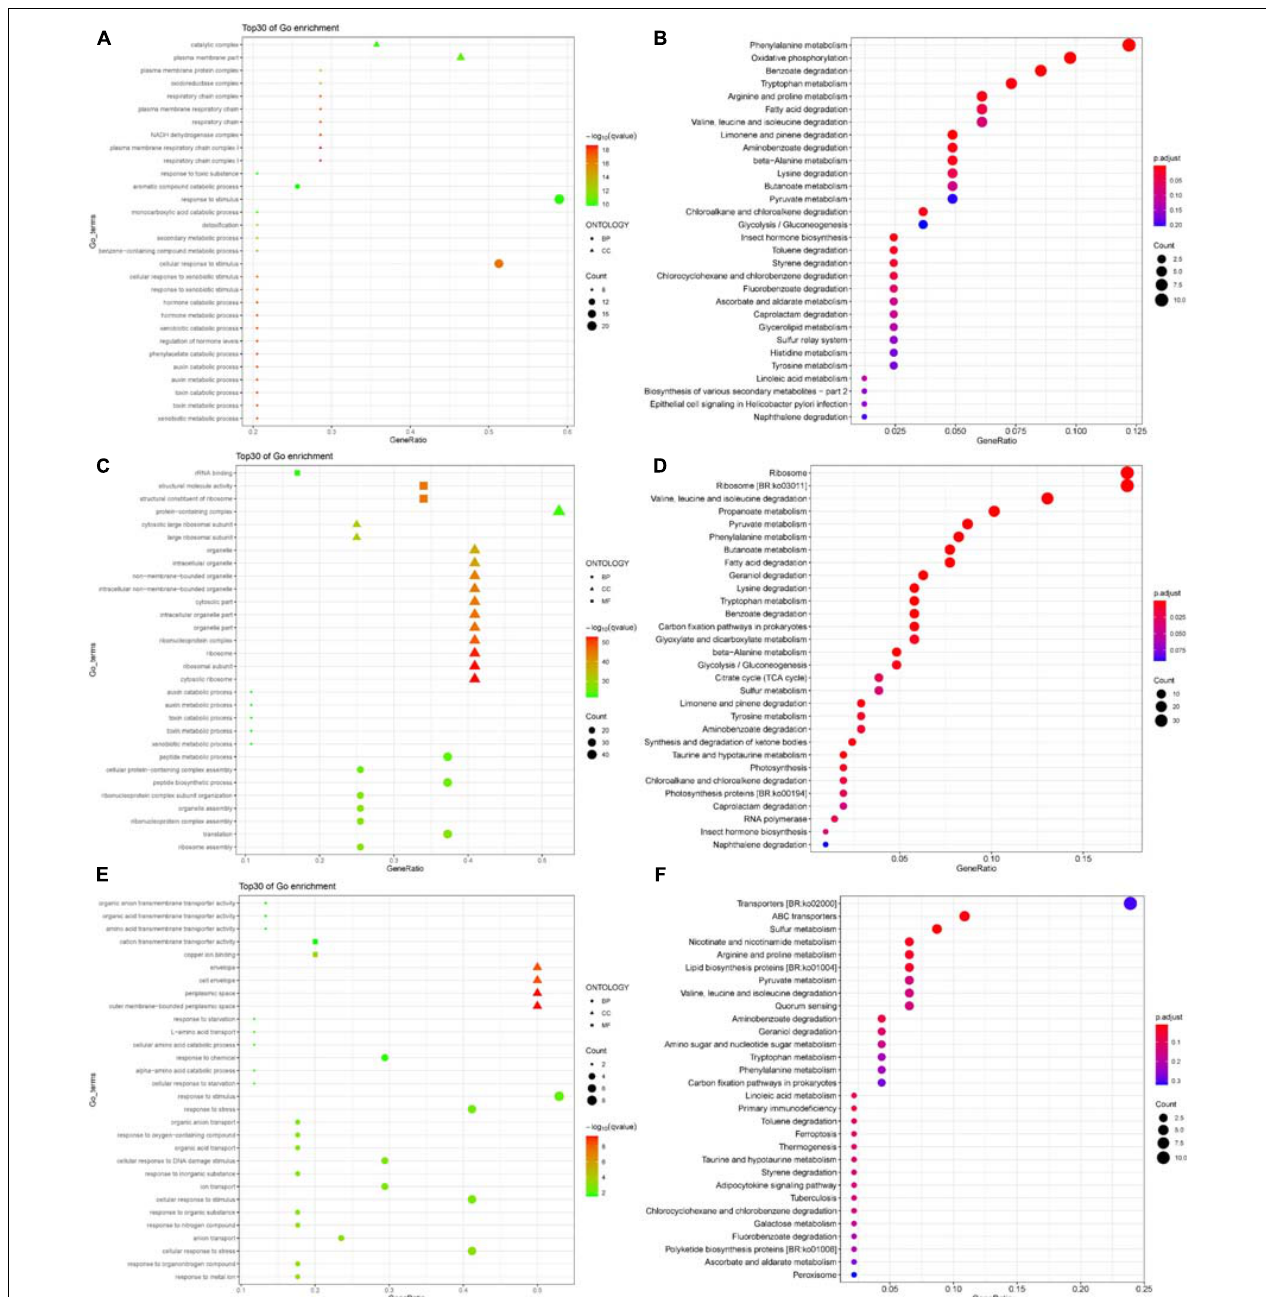
FIGURE 10 | (A) Top 30 GO enrichment terms of DEGs in (cid:49) abaI . The shape of the point indicates the different ontologies. The enrichment q -value of each GO term was normalized as negative log10( q -value) and is shown as a color gradient. The number of genes enriched in each GO term is represented by the size of the points. (B) The significantly enriched KEGG pathway of DEGs in (cid:49) abaI . The enrichment P -adjusted value of each pathway was shown as a color gradient. GeneRatio, number of DEGs/total number of genes in this KEGG pathway. The number of genes enriched in each pathway is represented by the size of the points. (C) Top 30 GO enrichment terms of DEGs in (cid:49) abaR . The shape of the point indicates the different ontologies. The enrichment q -value of each GO term was normalized as negative log10( q -value) and is shown as a color gradient. The number of genes enriched in each GO term is represented by the size of the points. (D) The significantly enriched KEGG pathway of DEGs in (cid:49) abaR . The enrichment P -adjusted value of each pathway was shown as a color gradient. GeneRatio, number of DEGs/total number of genes in this KEGG pathway. The number of genes enriched in each pathway is represented by the size of the points. (E) Top 30 GO enrichment terms of DEGs in (cid:49) abaIR . The shape of the point indicates the different ontologies. The enrichment q -value of each GO term was normalized as negative log10( q -value) and is shown as a color gradient. The number of genes enriched in each GO term is represented by the size of the points. (F) The significantly enriched KEGG pathway of DEGs in (cid:49) abaIR . The enrichment P -adjusted value of each pathway was shown as a color gradient. GeneRatio, number of DEGs/total number of genes in this KEGG pathway. The number of genes enriched in each pathway is represented by the size of the points.